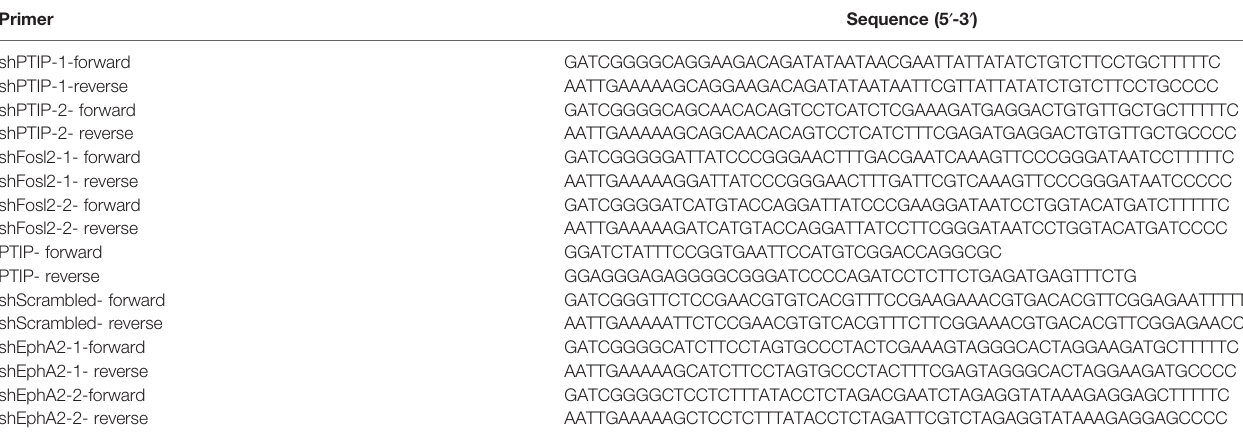
TABLE 1 | Primers used for plasmid construction.